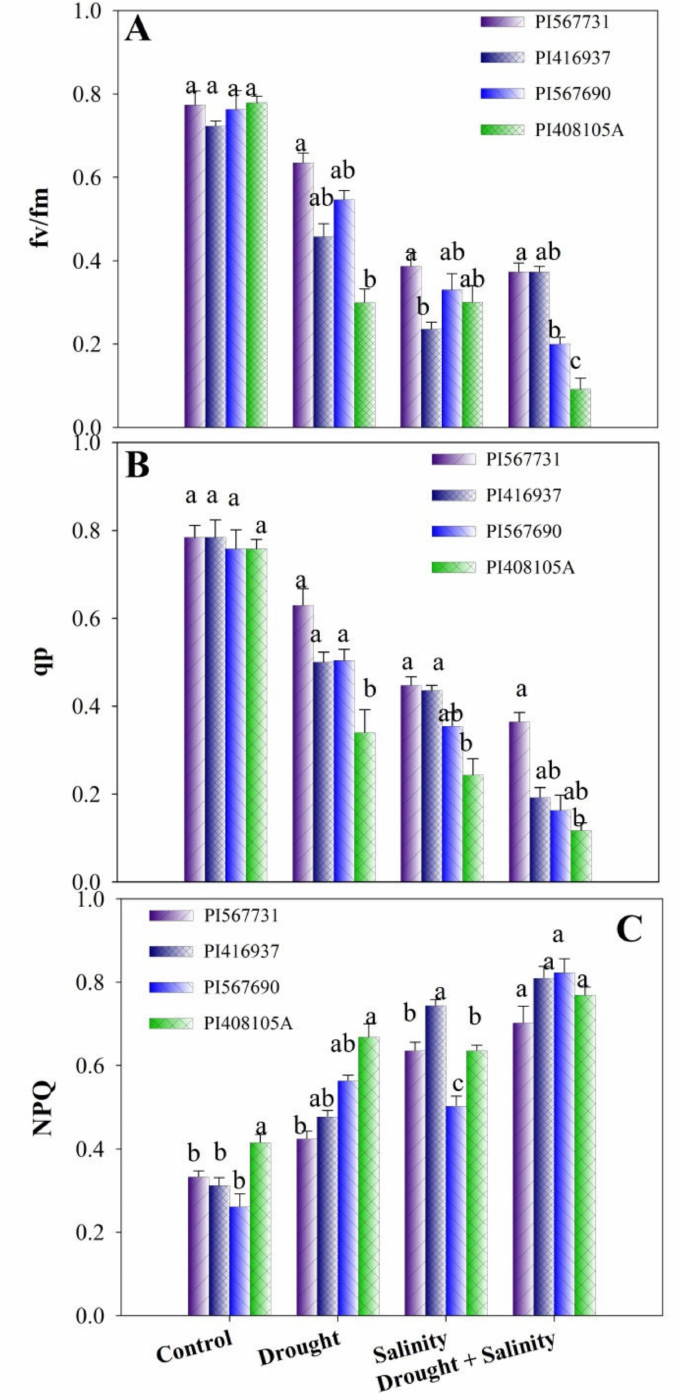
Figure 4. ( A ) Fv/Fm, ( B ) non-photochemical quenching (NPQ), and ( C ) photochemical quenching (qP) of four soybean cultivars grown under drought and salinity stress conditions. Data presented are means ± SD, and different letters denote a significant difference at p < 0.05 based on the least significant difference (LSD) test. Letter a is highly significant than b, and ab means no significant differences between a with ab and b with